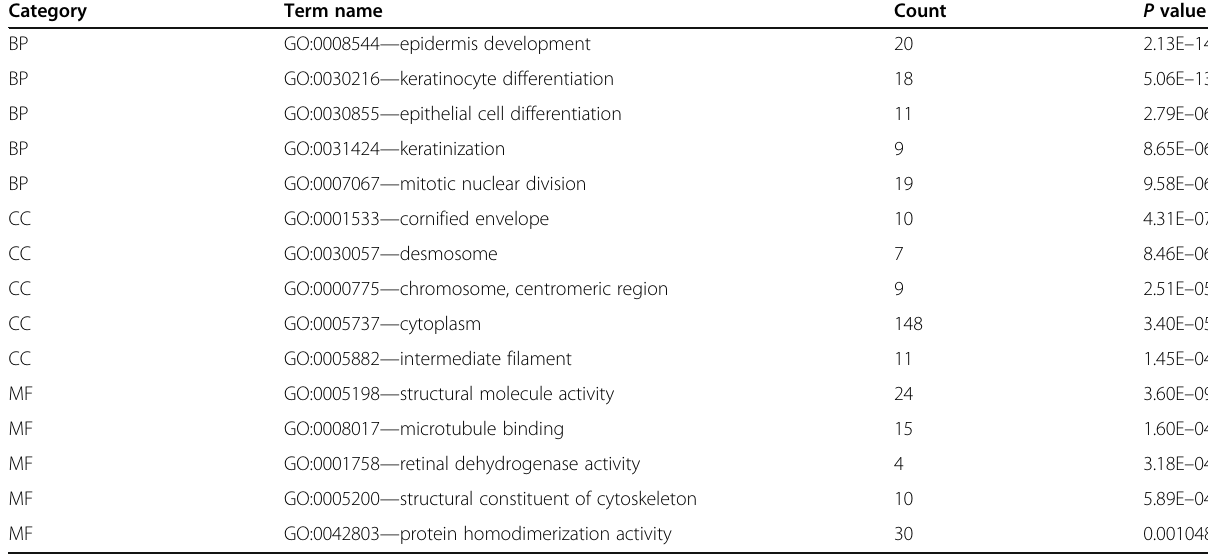
Table 1 The functional analyses of upregulated genes to identify top 15 GO terms Category